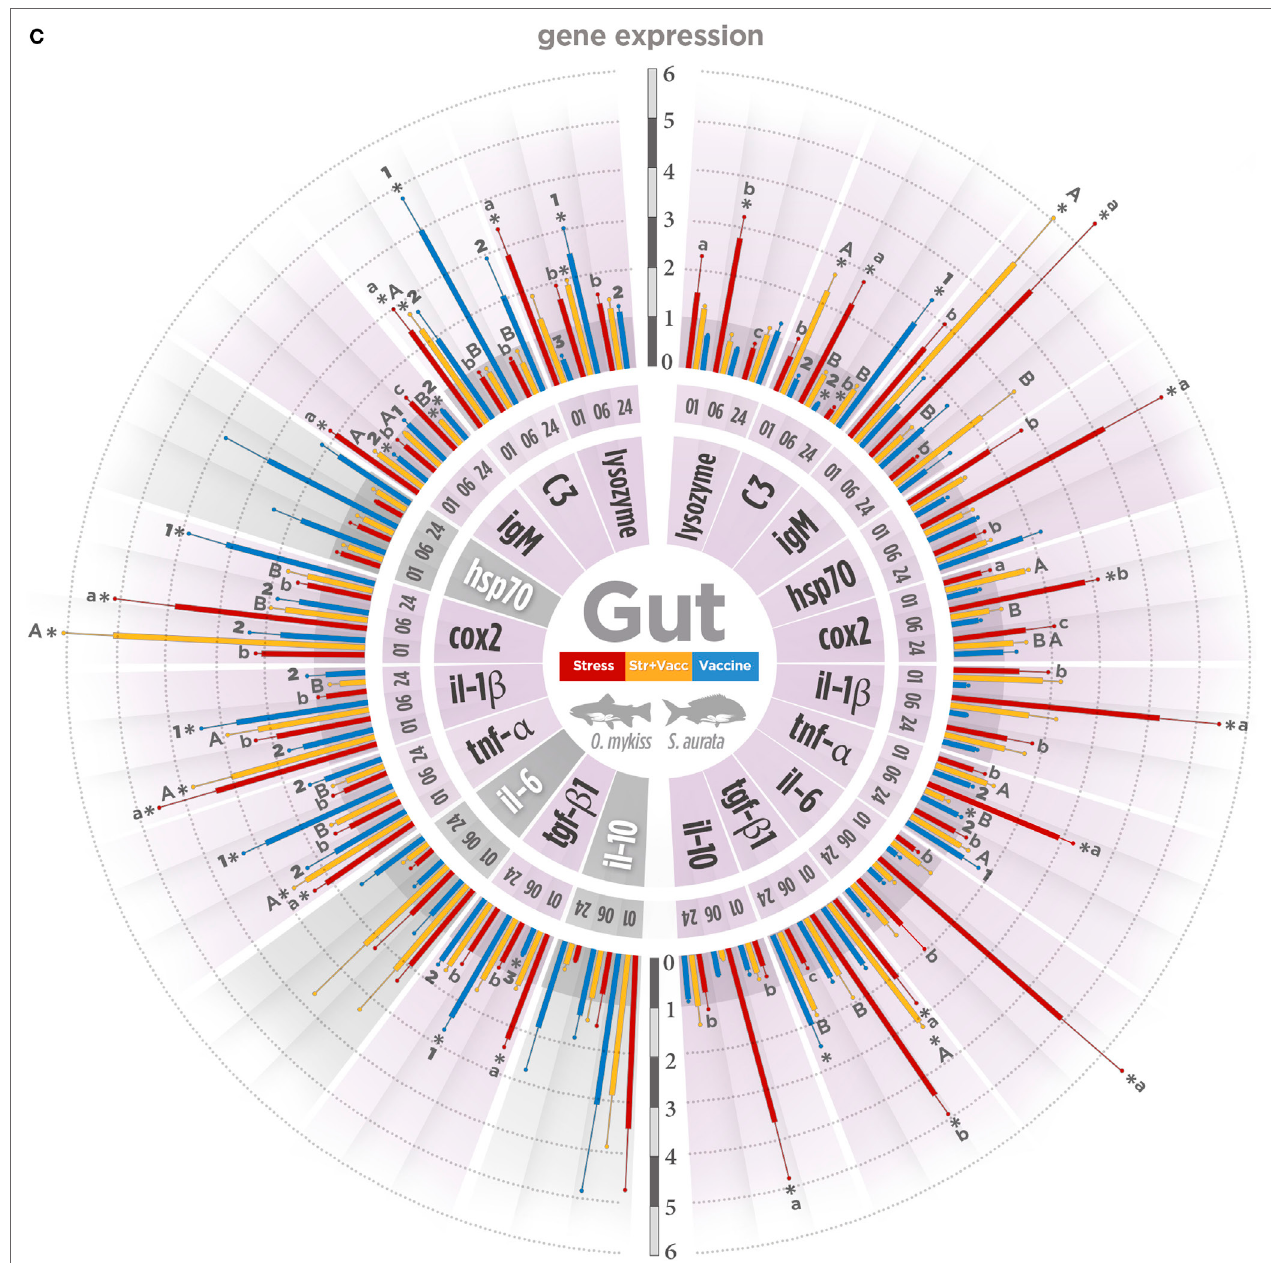
FigUre 4 | Gene expression level in gut-associated lymphoid tissue (GALT) after a biotic ( Vibrio anguillarum bacterin), abiotic (air exposure), or the combination of both stressors (vaccine + air exposure) at 1, 6, and 24 h post-stress. Quantitative real-time PCR quantification of specific mRNA immune and stress transcripts ( lysozyme , c3 , igm , hsp70 , cox2, Il1 β , tnf α , il6 , tgf β 1 , and il10 ) in (a) rainbow trout and (B) gilthead seabream. (c) Integrative comparison of GALT transcriptomic responses. β -Actin and 18s were chosen as housekeeping genes in rainbow trout and gilthead seabream, respectively. Different colors indicate different treatments: red (air exposure), orange (vaccine + air exposure), blue (vaccine), and gray (ctrl; control). Time zero represents the end of the acute air exposure stress (for the air exposure and the vaccine + air exposure) or 24 h after bath vaccination (for vaccine group). Data are represented as mean ± SE ( n = 8 per sampling time point). Significant differences are indicated by lower case in the air exposure group, by upper case in the vaccine + air exposure group, and by numbers in the vaccine group. Asterisk (*) indicates significant difference of each treatment versus control ( p <